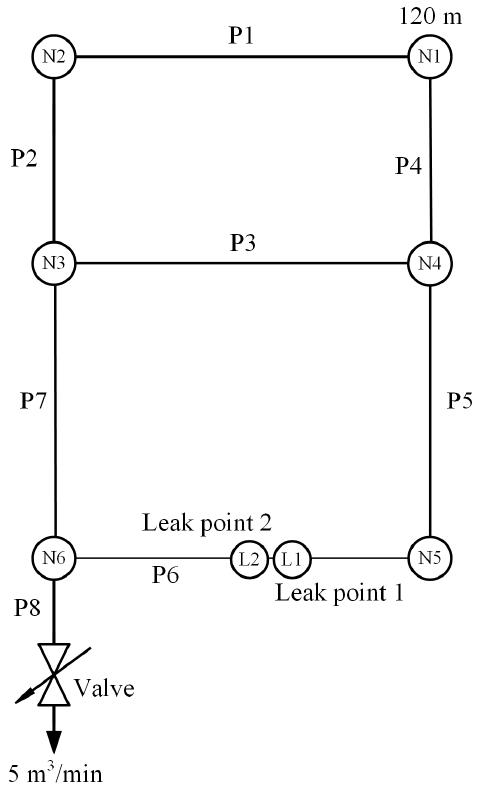
Figure 5. Configuration of synthetic pipe network A. Table 1. The characteristics of the synthetic pipe network A.